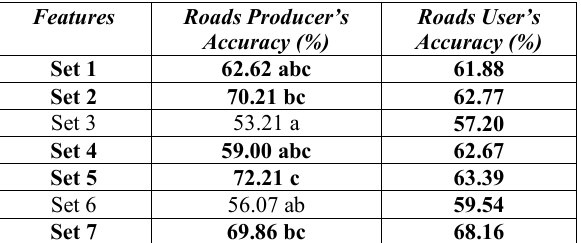
Table 9. Comparison of mean values of producer’s and user’s accuracies for “Roads” class and the seven sets of features tested.